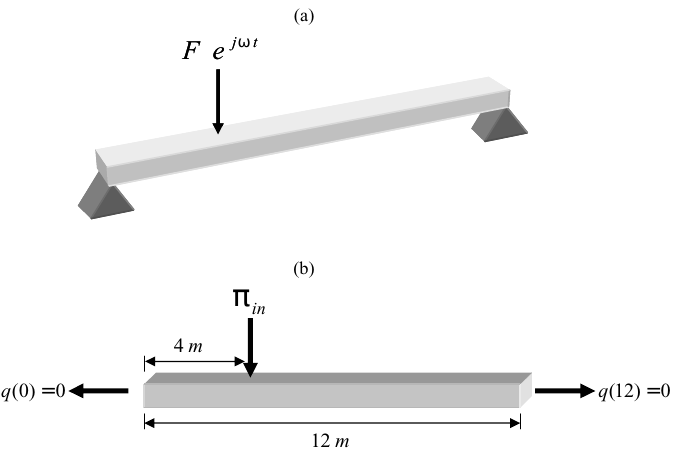
Fig. 1. Simply-supported beam. (a) Geometry of beam with transverse harmonic load. (b) Energy flow model with dimensions and zero energy flow boundary